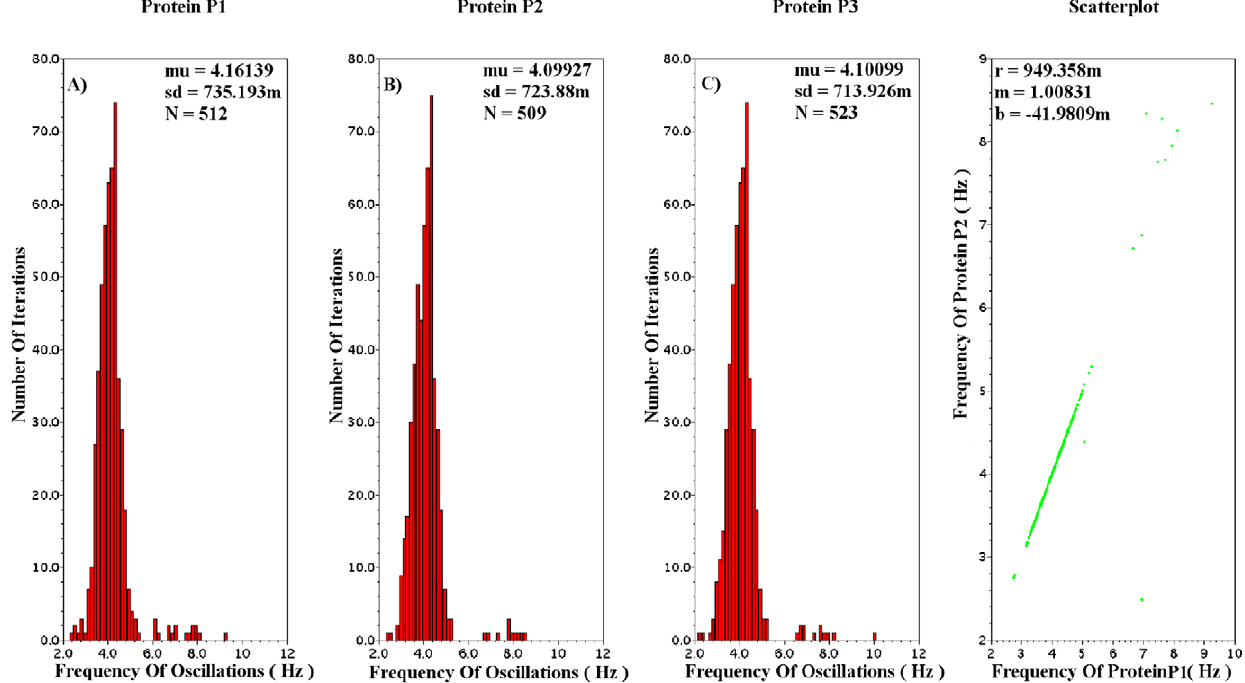
Figure 22. Monte Carlo Analysis for the three variable gene-protein regulatory Log-Domain circuit. Graph A corresponds to the various frequencies of oscillations of protein P1 during the 600 iterations of the analysis. Graphs B and C correspond to the various frequencies of proteins P2 and P3, respectively. The simulations have been performed for the current values presented in Tables 8 and 9. The number of successful oscillations is greater than 85 % .